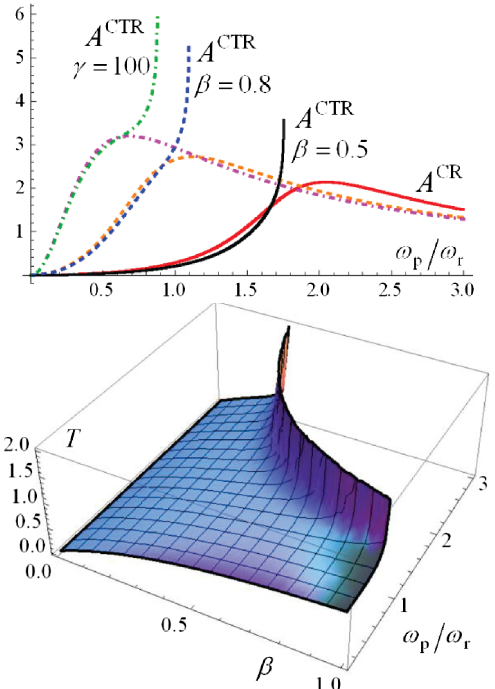
FIG. 3. The first modes of the CTR and CR amplitudes (top) and the ratio T ¼ A CTR =A CR (bottom), which is dependent on the charge velocity β and the ratio ω